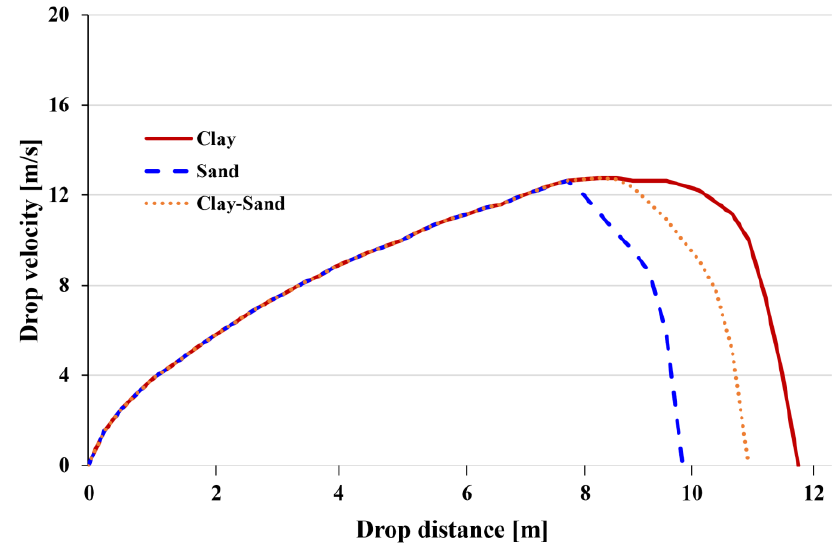
Figure 9. Comparison for drop velocity of anchor pile.